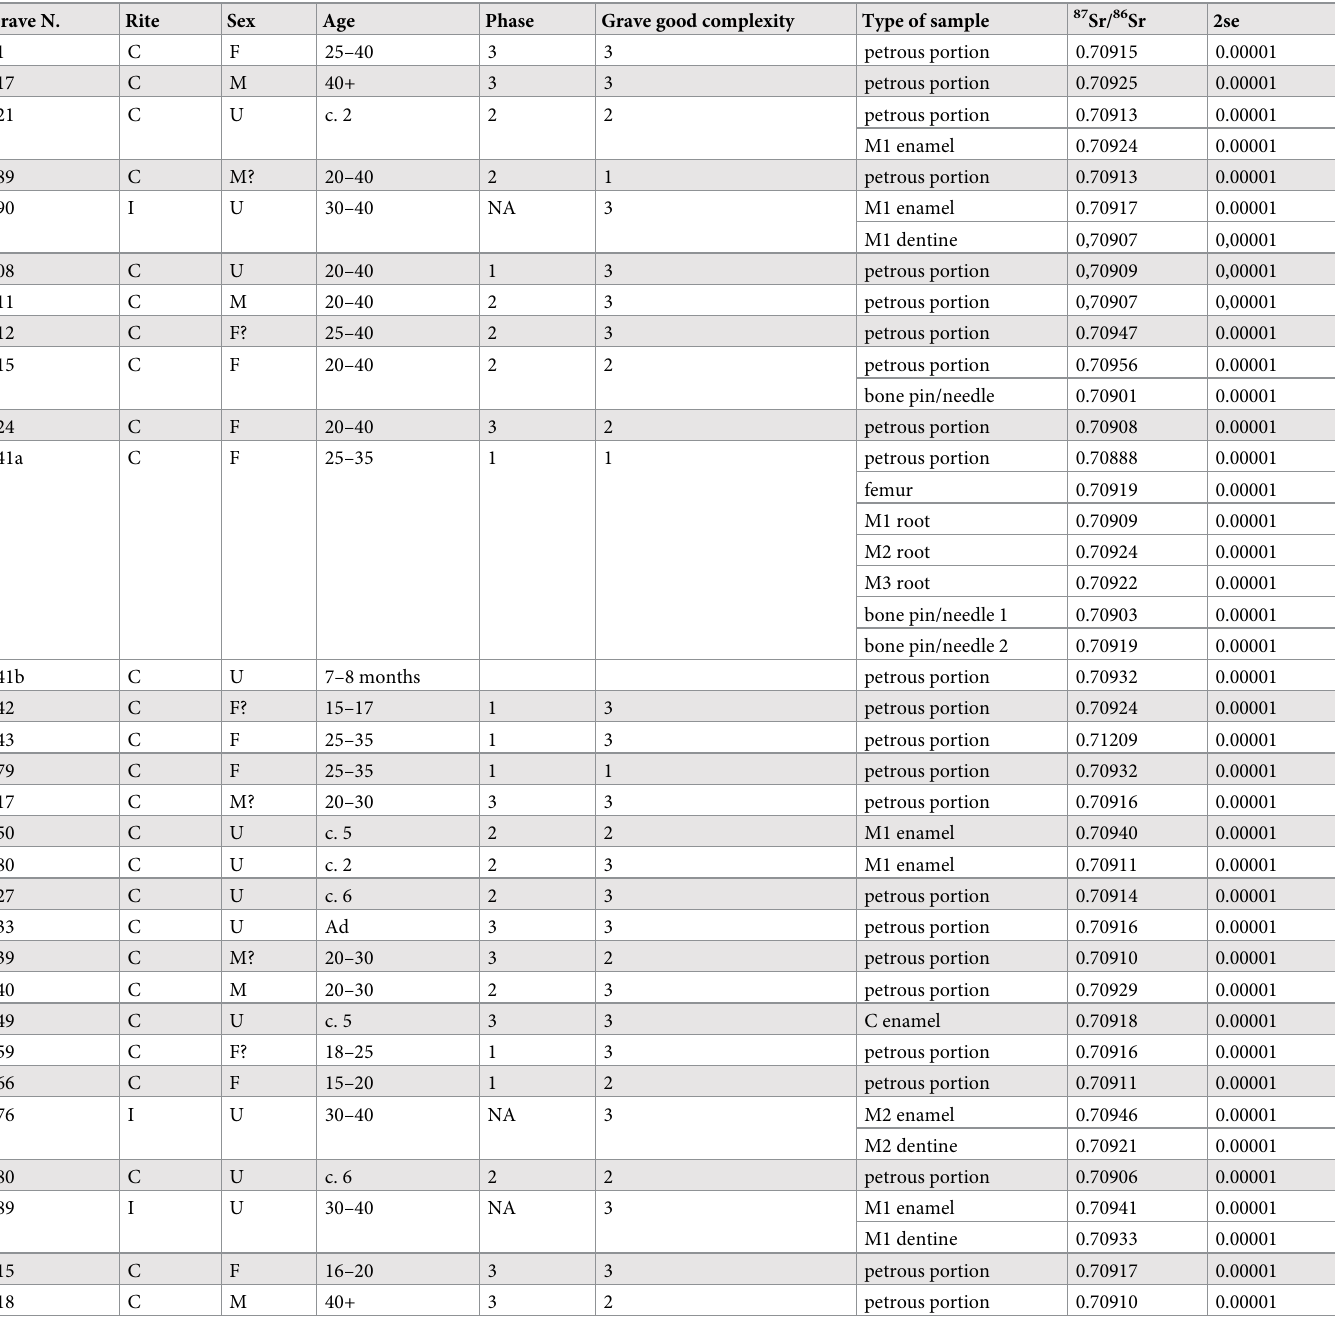
Table 5. Results of the